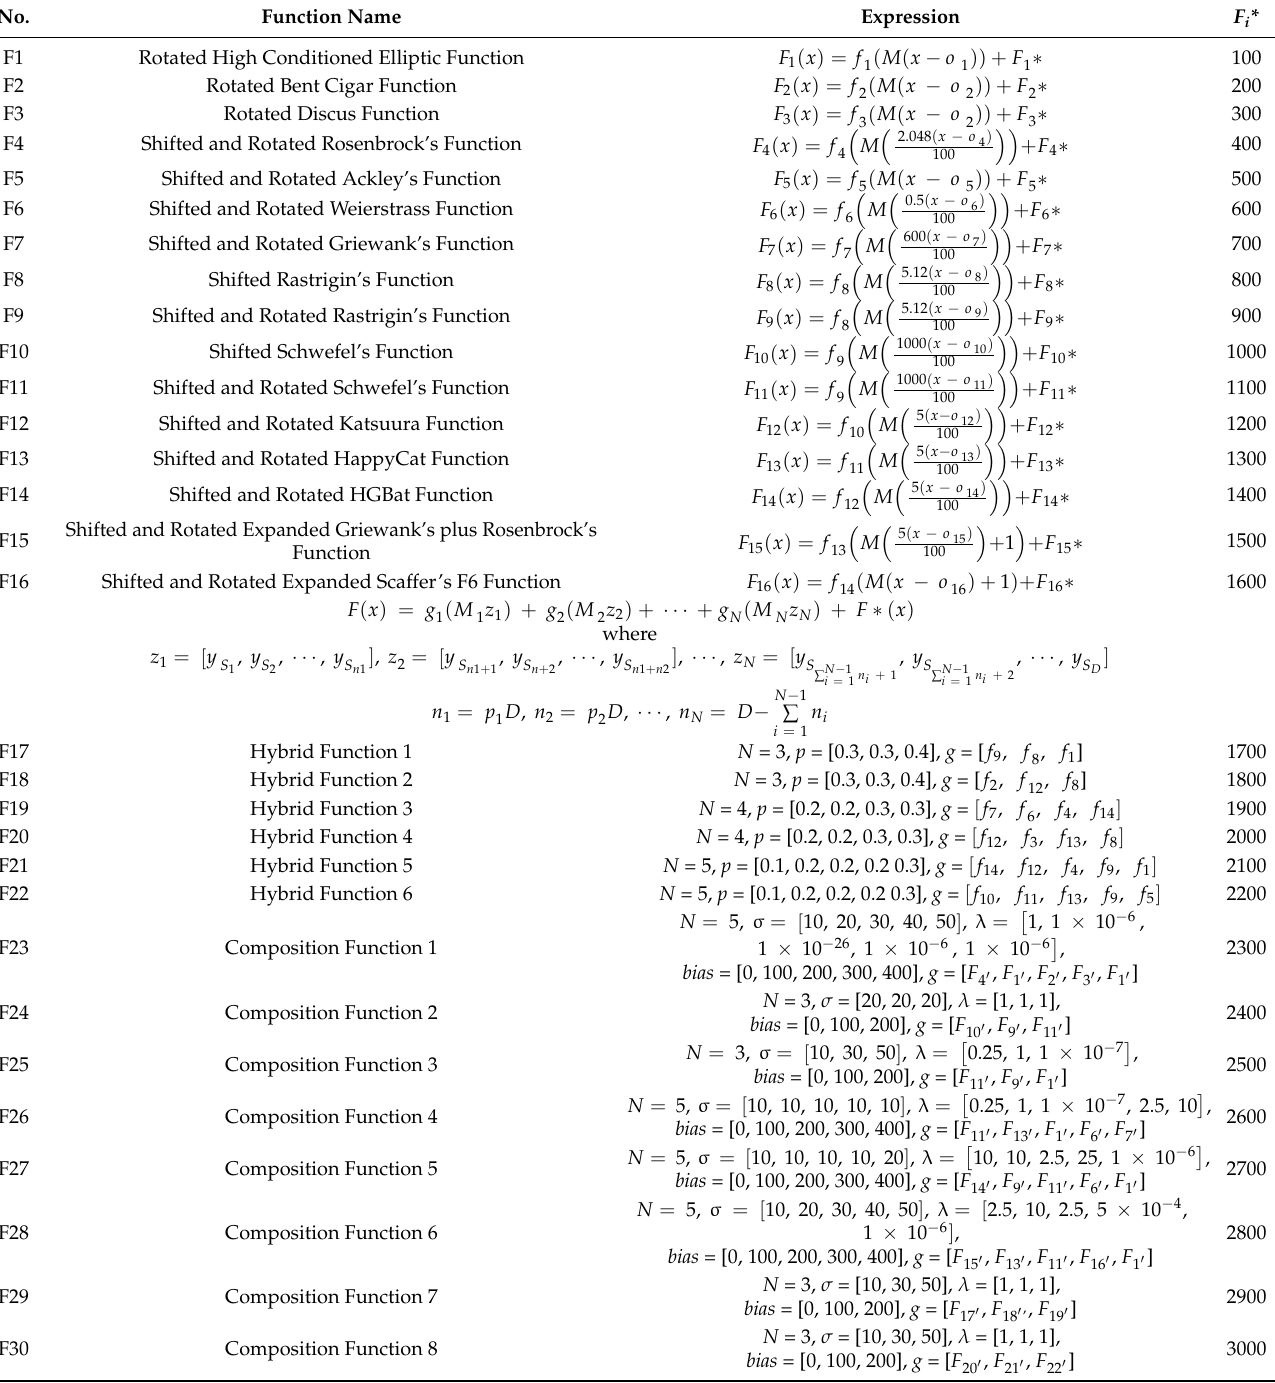
Table A1. Benchmarks in CEC